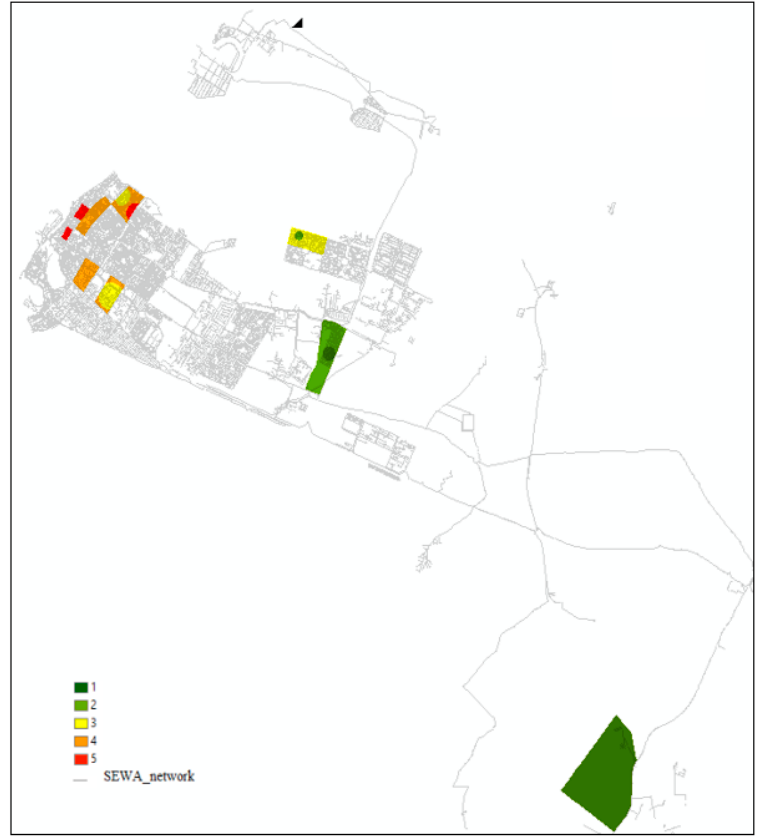
Figure 3. Physical parameters; length per junction map.